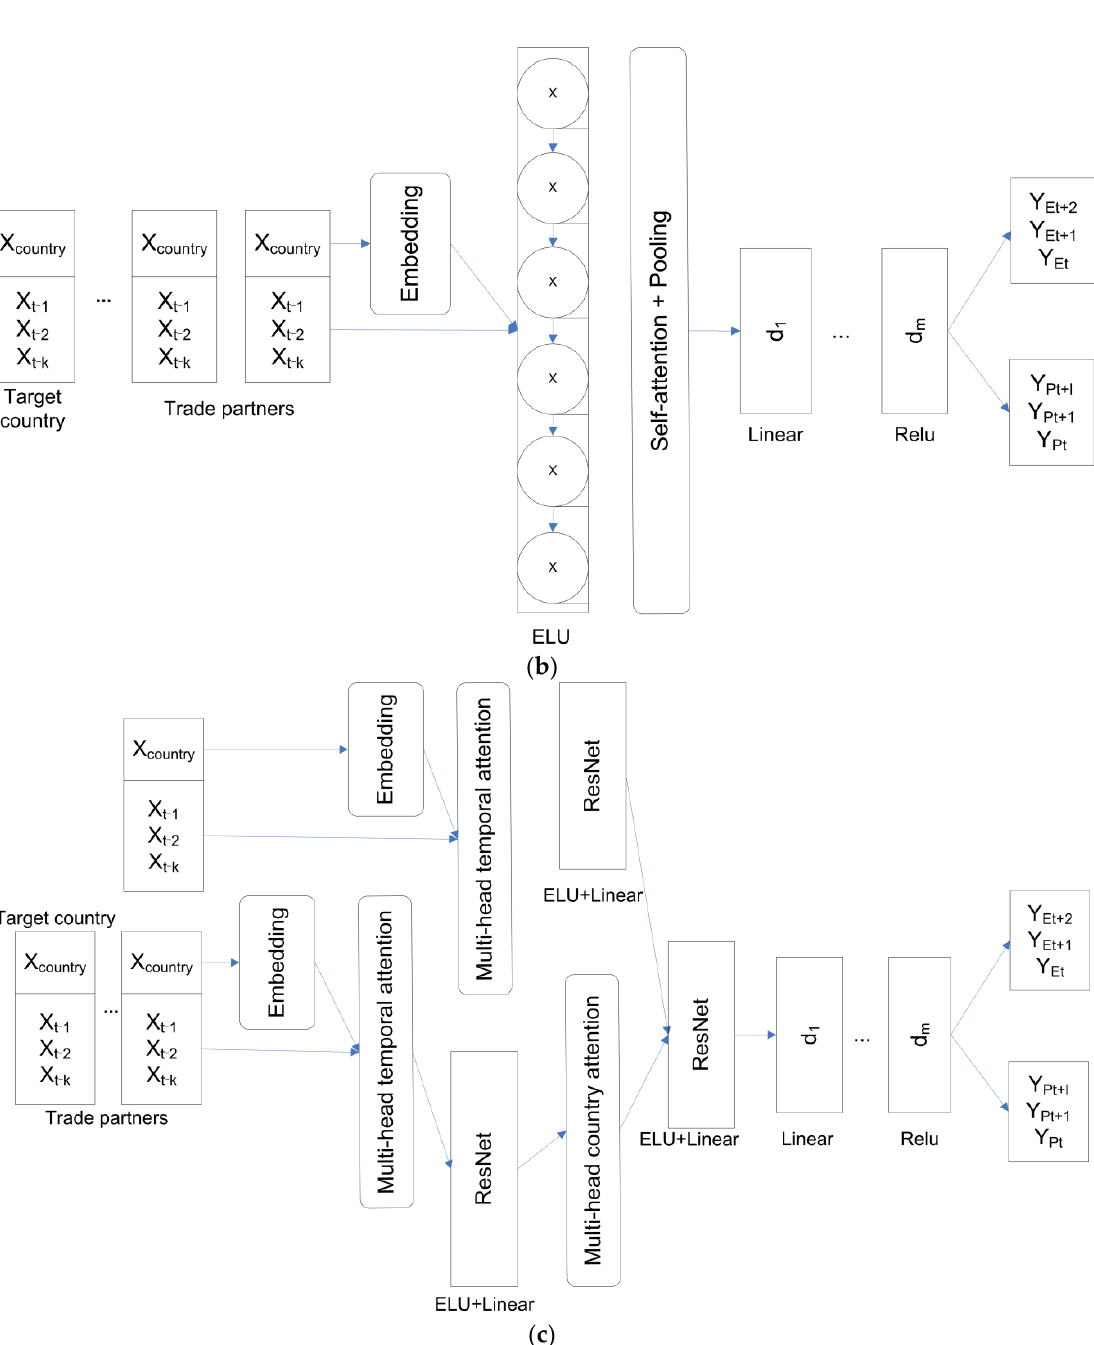
Figure 2. Neural network models to predict wheat export and production: ( a ) NARX model with self-attention. ( b ) recurrent network (LSTM/GRU/simple) with self-attention. ( c ) Transformer network with temporal and spatial attention.